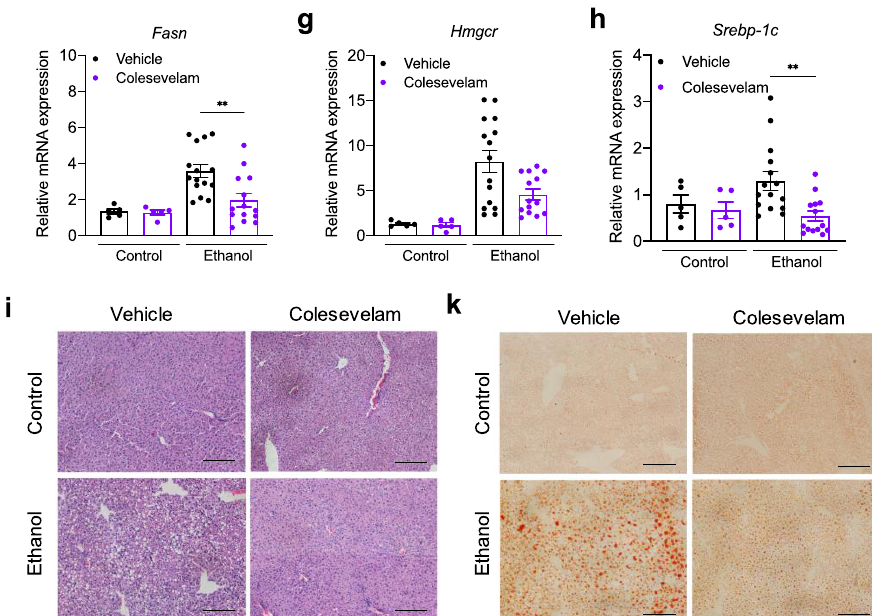
Figure 3. Colesevelam treatment ameliorates ethanol-induced liver steatosis in gnotobiotic mice subjected to the chronic- plus-binge ethanol feeding model. C57BL/6 germ-free mice were colonized with feces from two patients with alcoholic hepatitis and subjected to the chronic-binge ethanol feeding model ( n = 15 in vehicle treatment and n = 14 colesevelam treatment) or isocaloric diet ( n = 5 per group), and given vehicle or colesevelam in the liquid diet. ( a ) Serum level of alanine aminotransferase (ALT). ( b ) Serum level of alkaline phosphatase (ALP). ( c ) Hepatic triglyceride content. ( d ) Hepatic cho- lesterol content. Hepatic Acc1 ( e ), Fasn ( f ), H mgcr ( g ), and Srebp1c mRNA ( h ). ( i ) Representative liver sections after hema- toxylin and eosin staining. ( k ) Representative Oil Red O-stained liver sections. Results are expressed as mean ± s.e.m. p values were determined by one-way ANOVA with Tukey’s post-hoc test. ** p < 0.01, *** p < 0.001. Bar size = 100 μm.